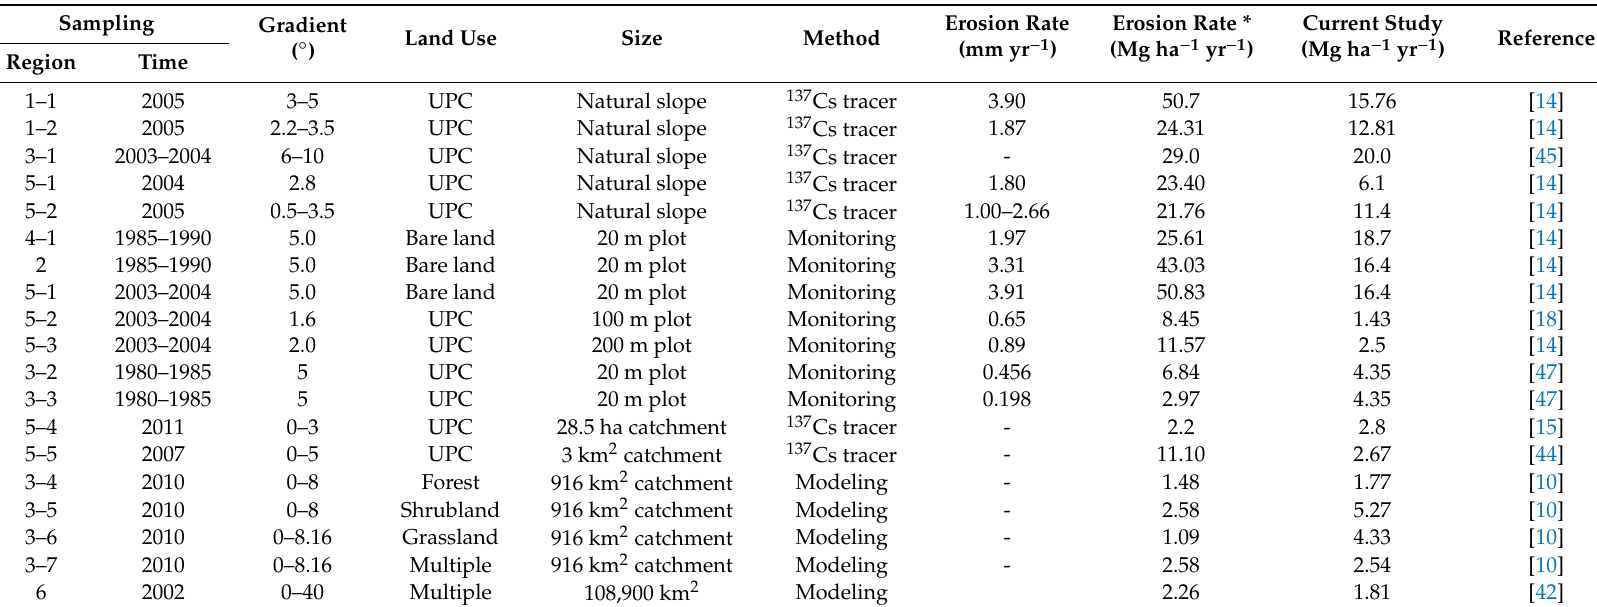
Table 3. The published rates of soil erosion in the black soil region (the study area locations of the references were labeled in Figure 1).